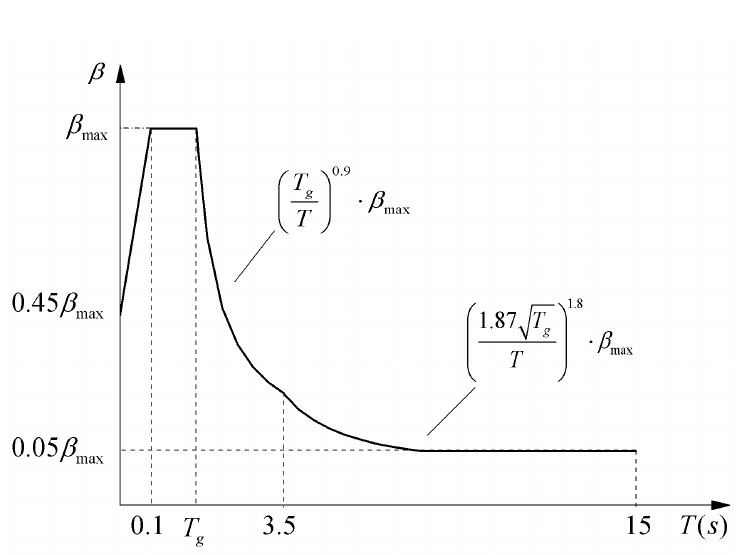
Fig. 7 Long-period seismic design β spectrum with 5% damping